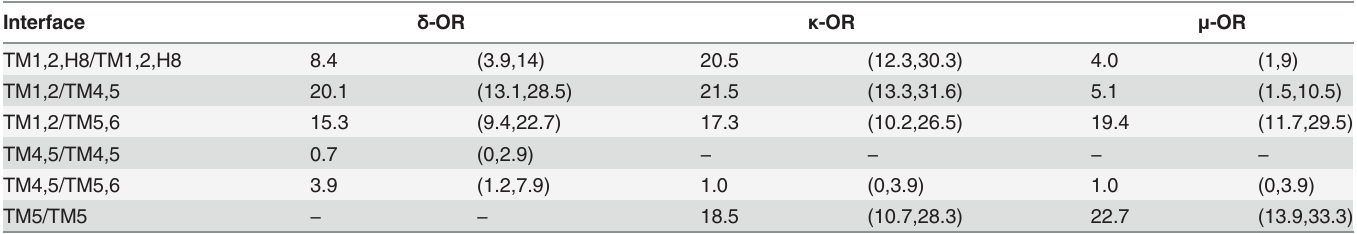
Table 3. Association rates of OR homo-dimers formed during five independent MD simulations of the μ -OR/ μ -OR, κ -OR/ κ -OR, δ -OR/ δ -OR, δ -OR/ μ - OR and δ -OR/ κ -OR systems. Interface